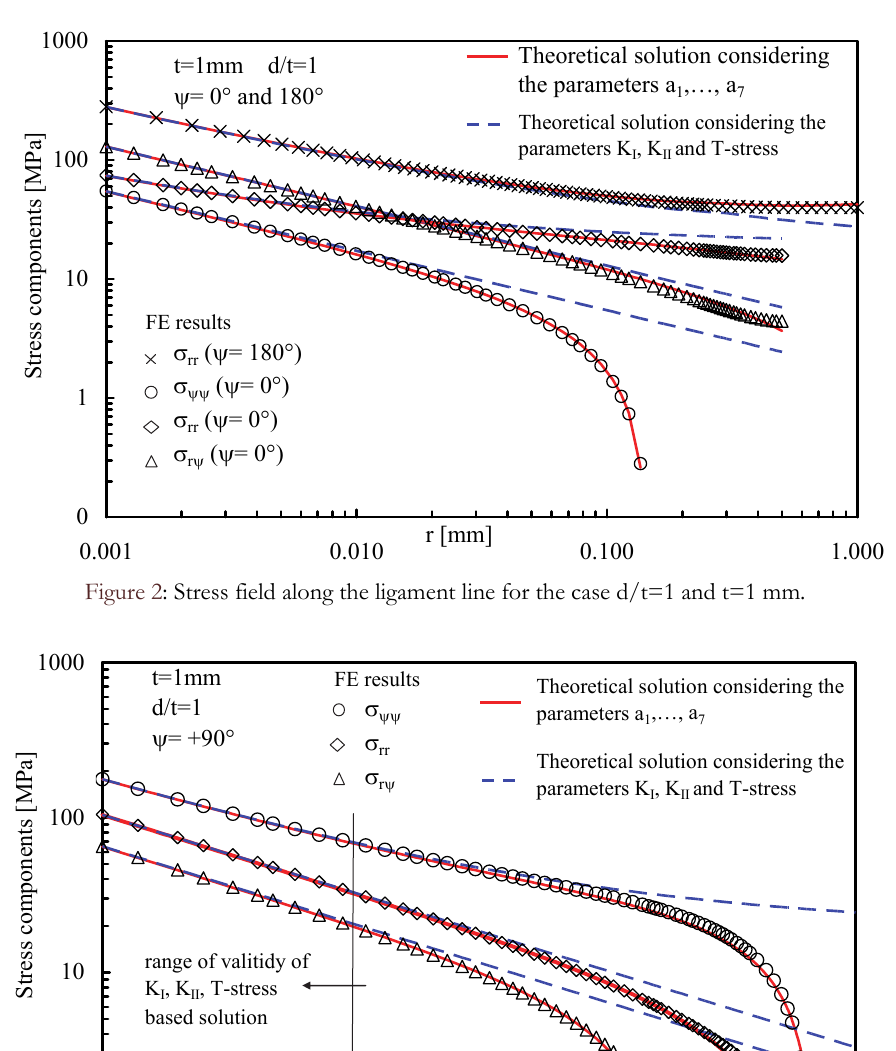
Table 2. Mean values of the strain energy density over the control volumes for welded lap joints, with F/(t  1)=10 MPa; values based on T* determined on the ligament, close to the point of singularity, r  0.03 mm